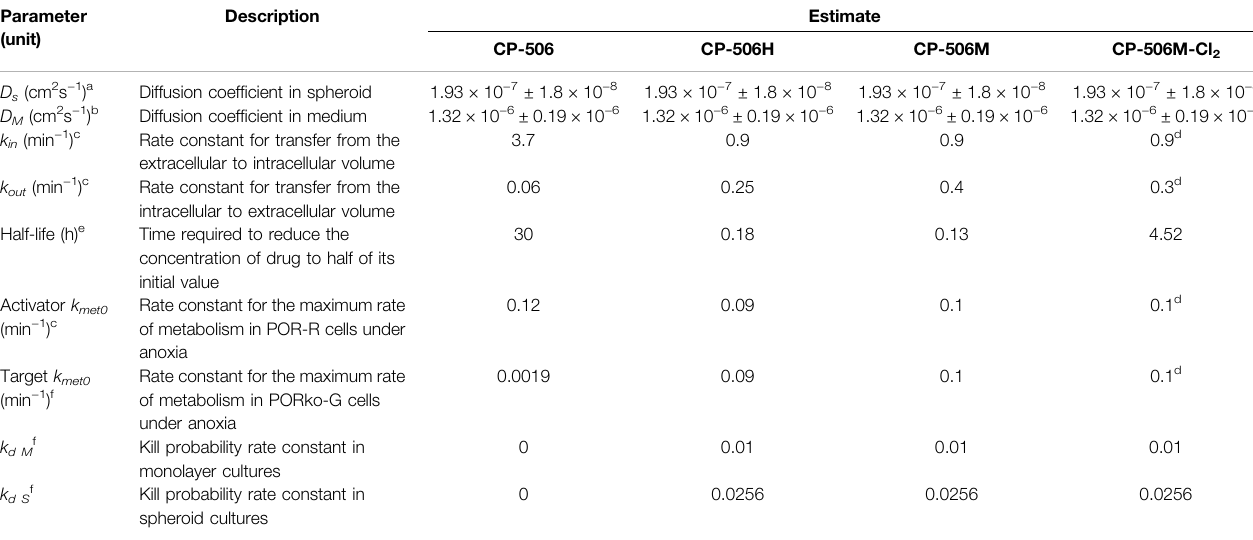
TABLE 1 | CP-506 PK/PD parameters used for ABM